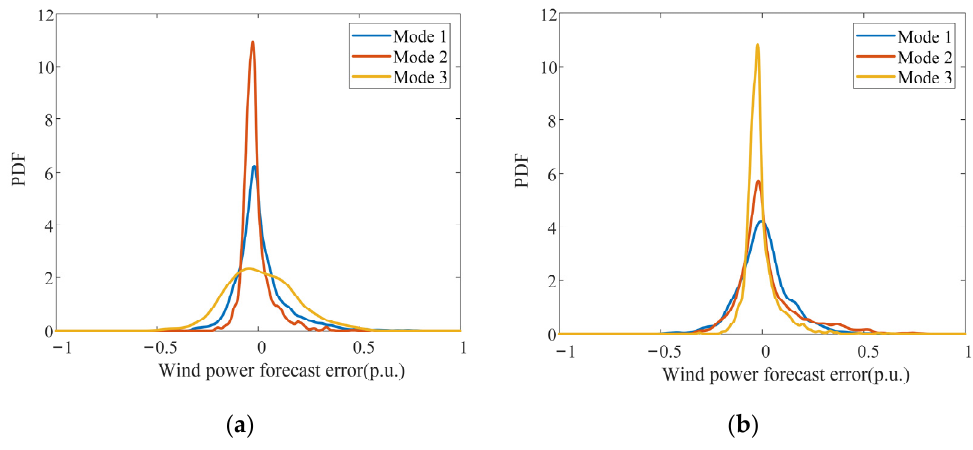
Figure 8. PDF curves of each MDIF mode in season 1: ( a ) obtained by MNSGA-II-Kmeans; ( b ) ob- tained by Kmeans. Table 1. Comparison of the clustering results of MNSGA-II-Kmeans and Kmeans.